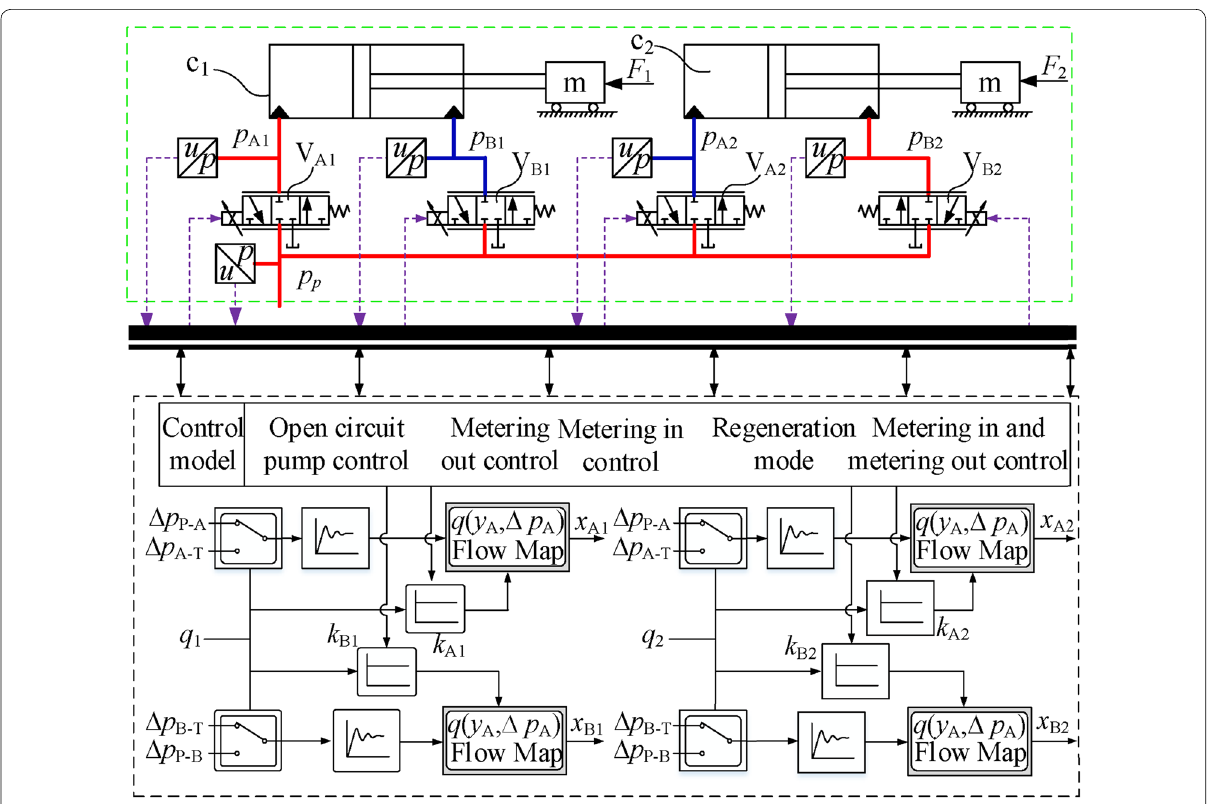
Figure 11 Flow distribution